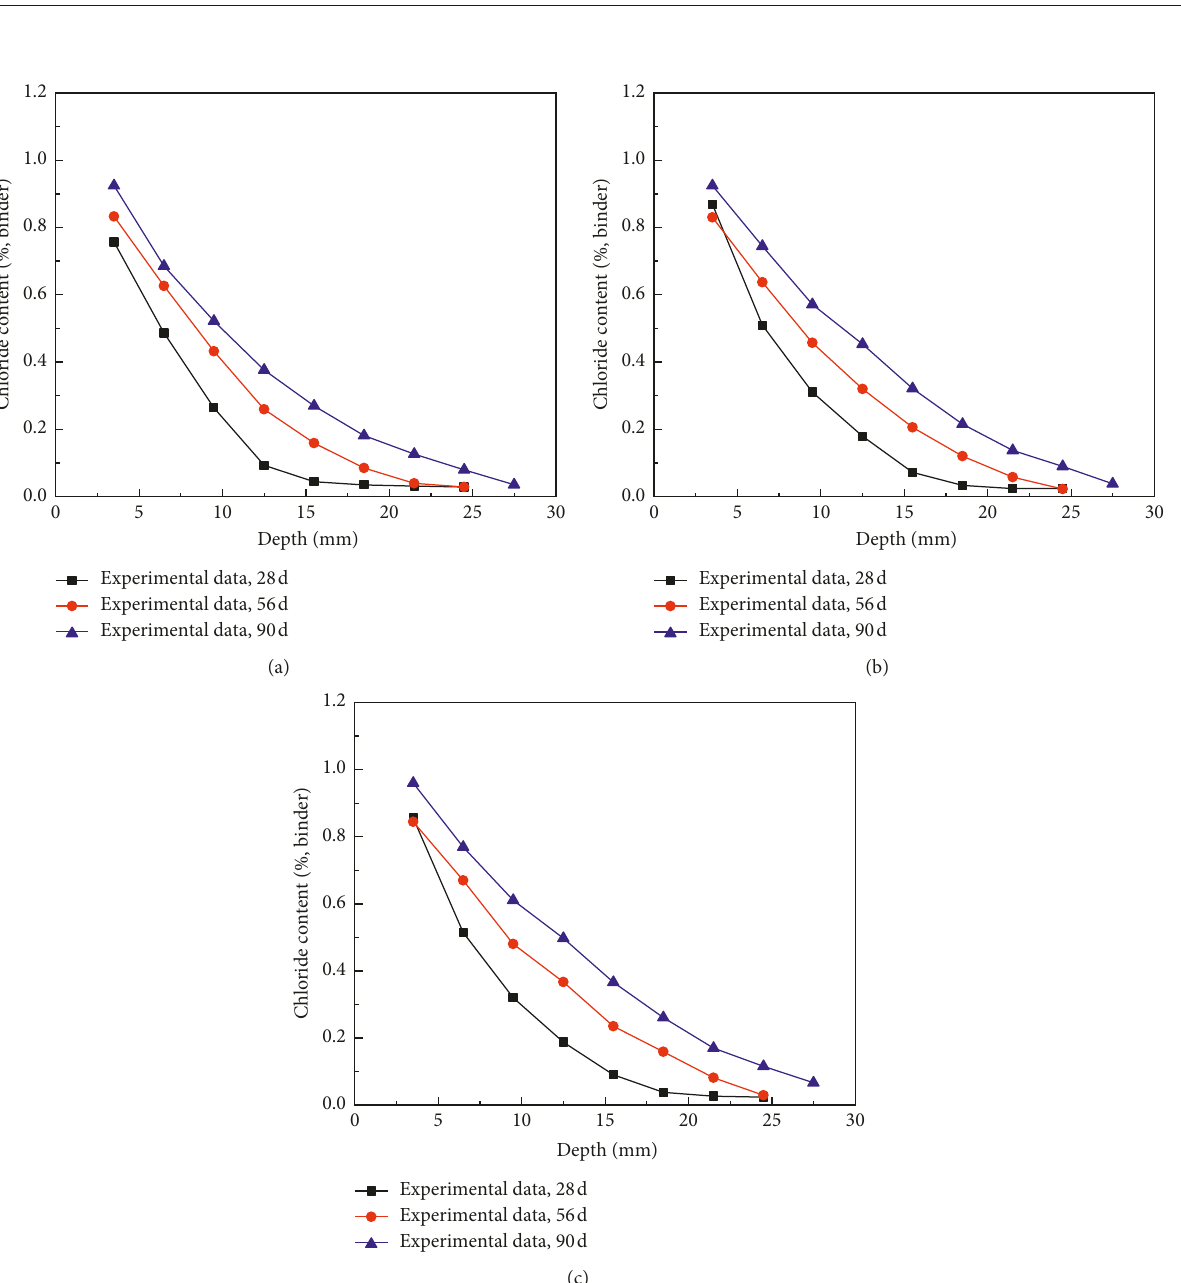
Figure 7: Chloride profiles obtained from the diffusion tests: (a) w/b � 0.4; (b) w/c � 0.45; (c) w/b �